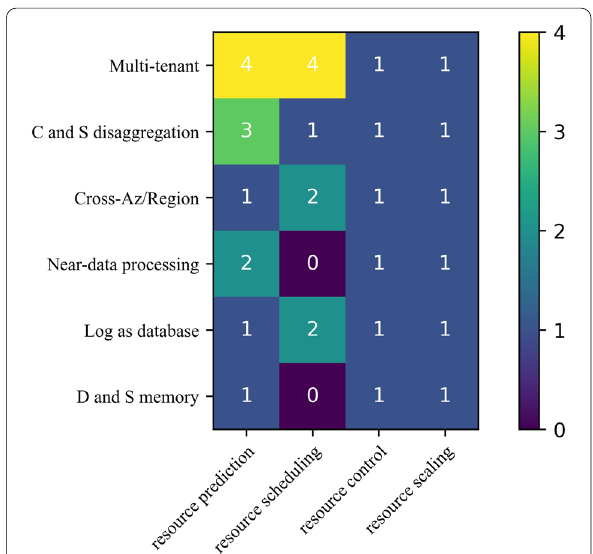
Fig. 4 Maturity level of the interleaving of two dimensions (an example)